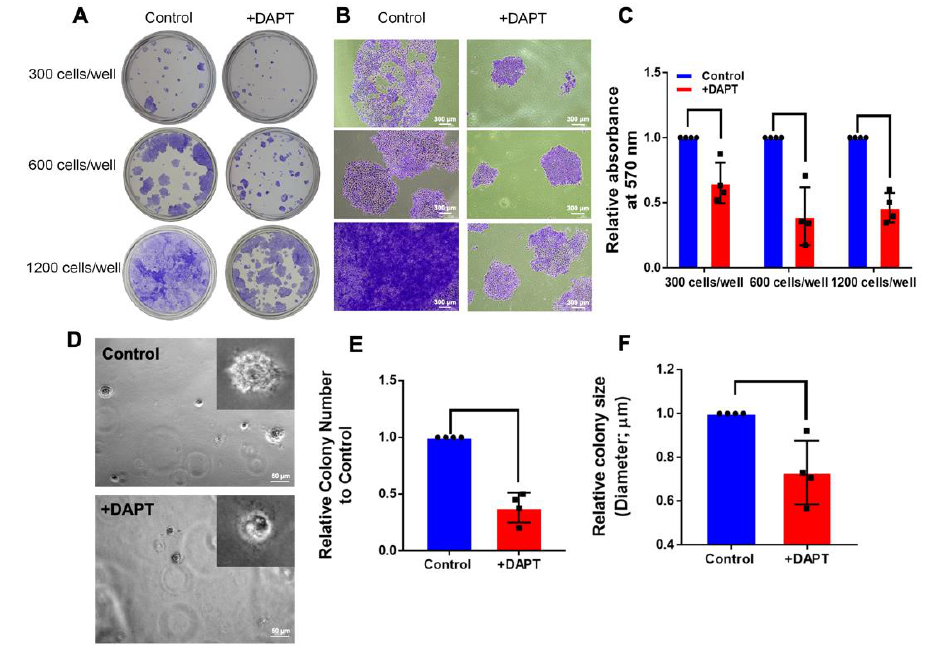
in evaluating the tumorigenic activity of HSC-4 cells after treatment with DAPT. HSC-4 0.5% DMSO (Control) or 50 μM DAPT for 14 d. The results revealed that colony size was (Figure 5E,F). onies were significantly lower in the DAPT-treated cells, compared with the control group (Figure 5E,F).